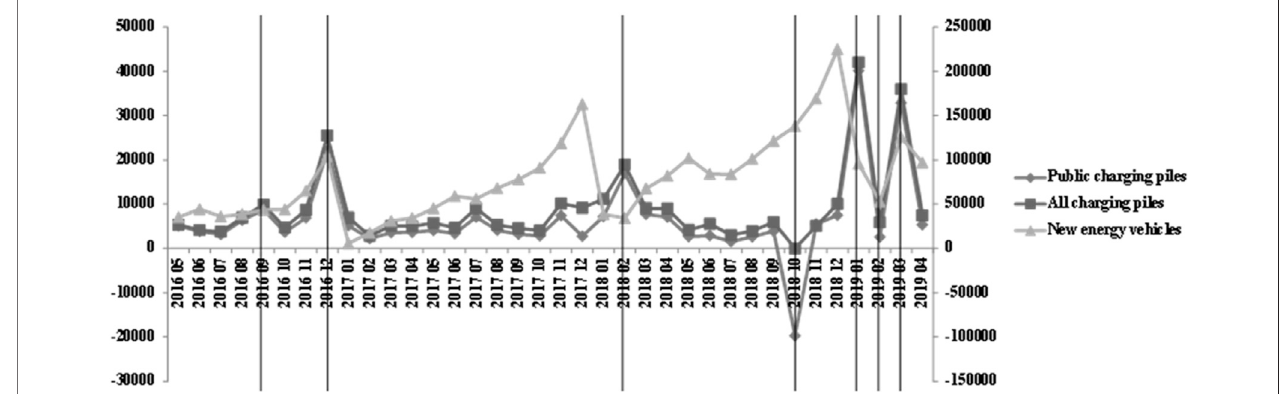
FIGURE 2 | Trends of the numbers of new-energy vehicles, all charging piles, and public charging piles.